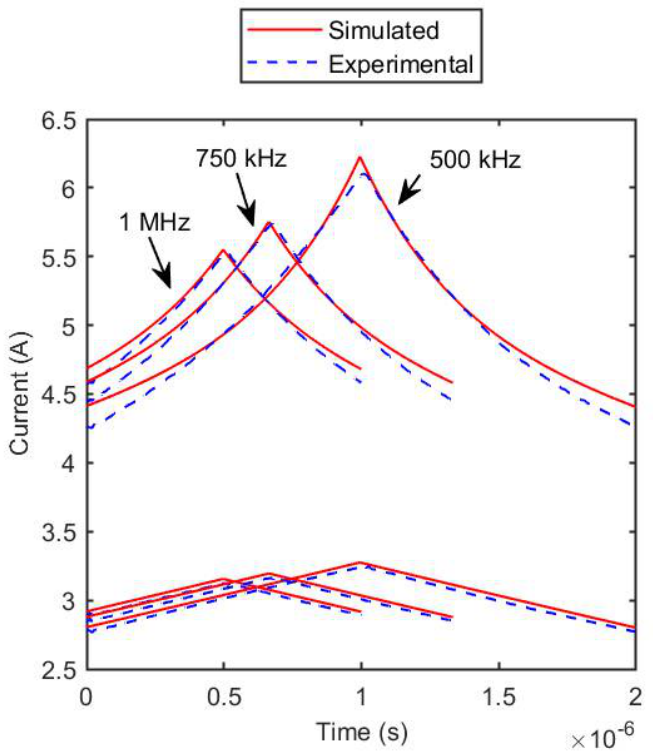
Figure 17. Coilcraft MSS1260T-273 inductor. Comparison of experimental and simulated current waveforms for different output current values and different switching frequencies.